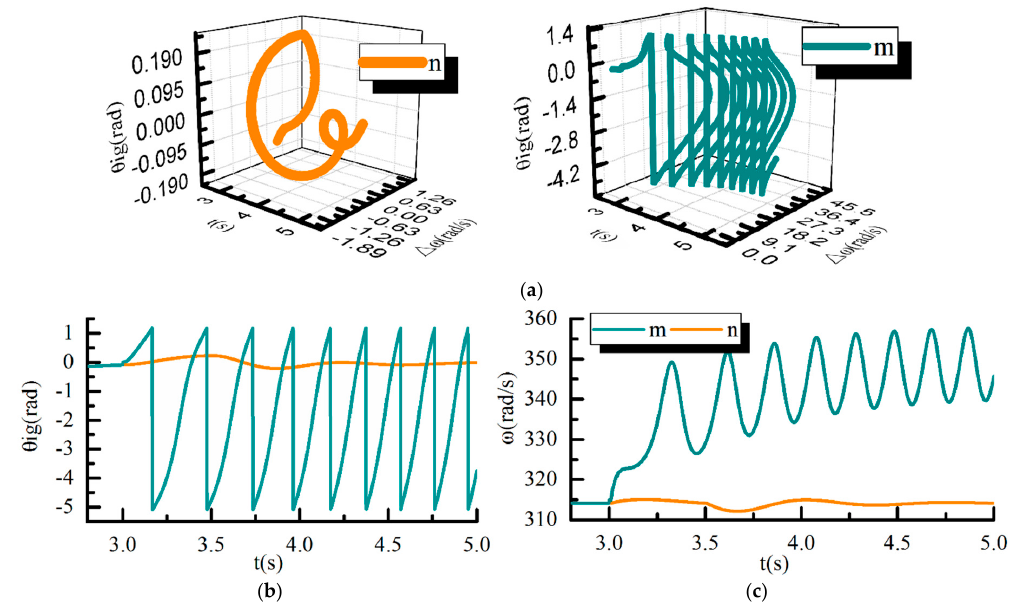
Figure 9. Comparison of simulations when fault clearing time are different. ( a ) Operational trajectories; ( b ) Angle difference; ( c ) Angular frequency of the IIDG.